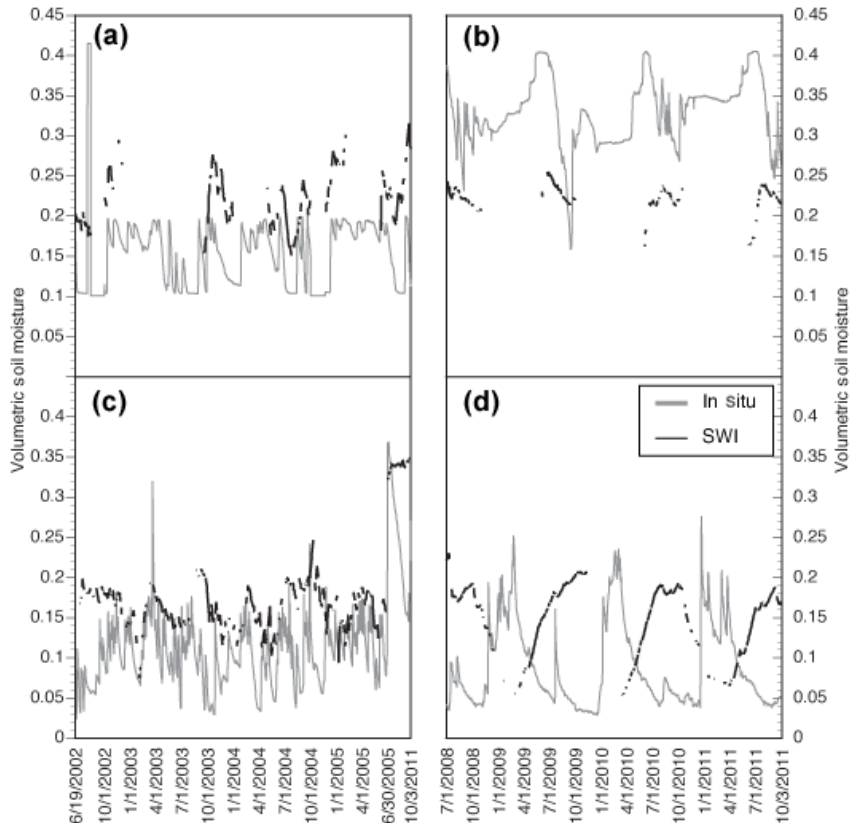
Figure 10. Selected time series associated with poorly performing (NS < 1.00) outliers with in situ data as solid gray and SWI estimates in dashed black. Panel (a) shows an example of problematic in situ data. Panel (b) is an example where there was insufficient SWI data. Panel (c) illustrates an SWI dataset that lacked the dynamic range present in the in situ data. Panel (d) depicts a discrepancy in timing between SWI and in situ datasets. Dates are indicated in mm/dd/yyyy